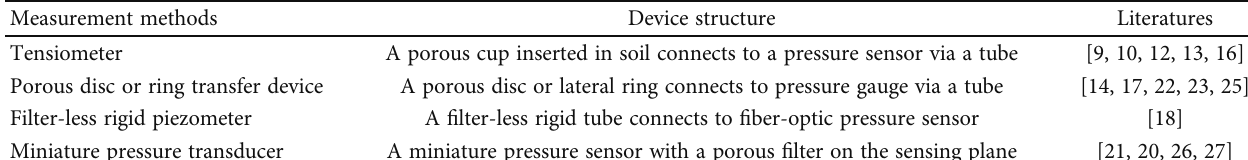
Figure 1: Four methods to measure PWP in freezing, thawing, and partially frozen soils. (a) Tensiometer, (b) porous disc, (c) fi lter-less rigid piezometer [18], and (d) miniature pressure transducer. Table 1: Publication on PWP measurement in freezing, thawing, and frozen soils.